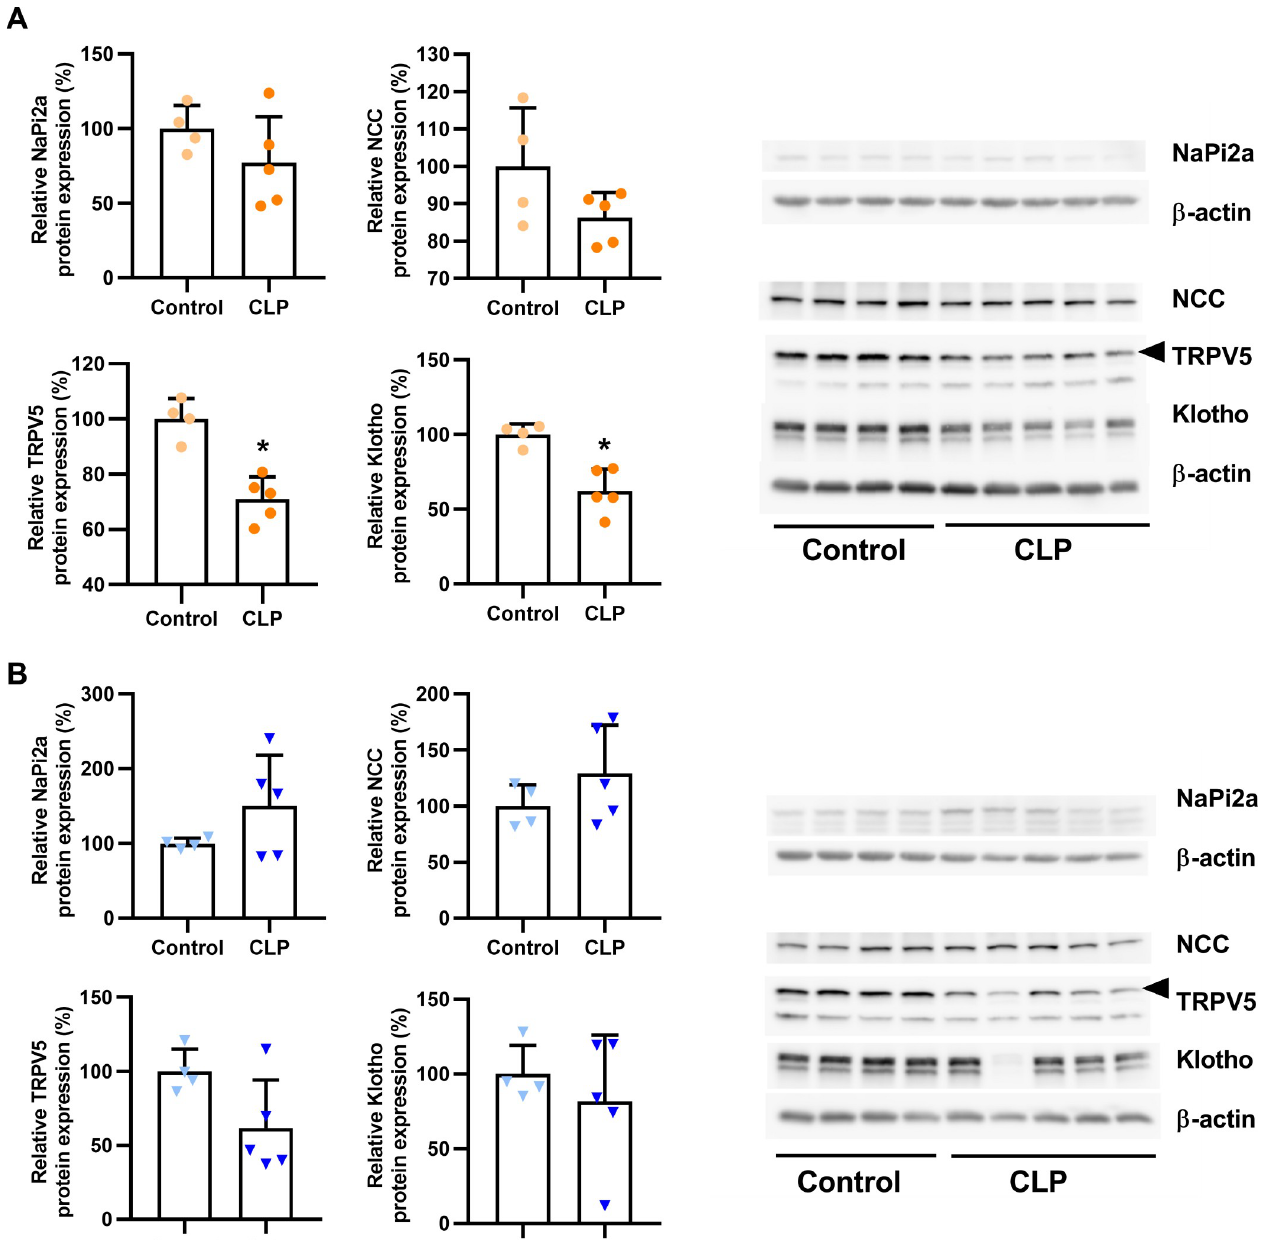
Fig 5. Effects of CLP-induced sepsis on the renal expression of phosphate-, sodium- and calcium-transporting proteins and of Klotho. Quantification and original western blot images of Napi2a, NCC, TRPV5 and Klotho protein expression detected in renal total membrane fractions of (A) female and (B) male healthy control and CLP mice, 48 h post-surgery. Each bar represents the mean ± SD of 4–5 mice per experimental group. Each symbol represents the mean of an individual sample measured on two membranes. � , P < 0.05 vs. healthy control, Student’s t-test with Welch correction.